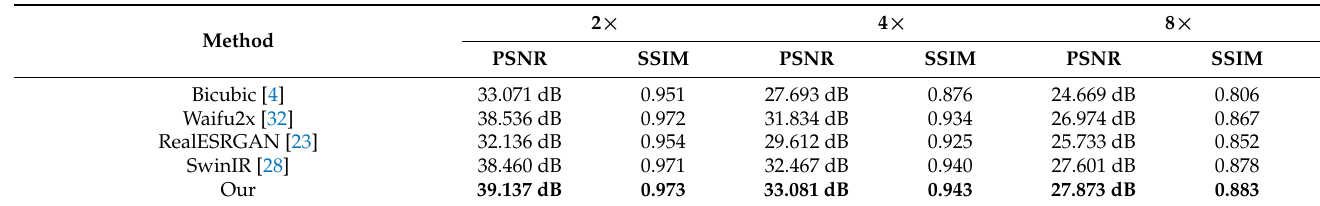
Table 4. Comparison with other super-resolution methods on the AnimeCharacter12 test dataset (12 images). The final result is the average result of 12 test images in the AnimeCharacter12 test dataset (best results are indicated with bold). N = 12.